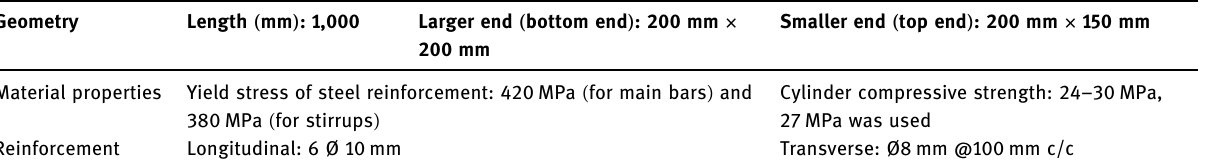
Material properties Yield stress of steel reinforcement: 420 MPa ( for main bars ) and